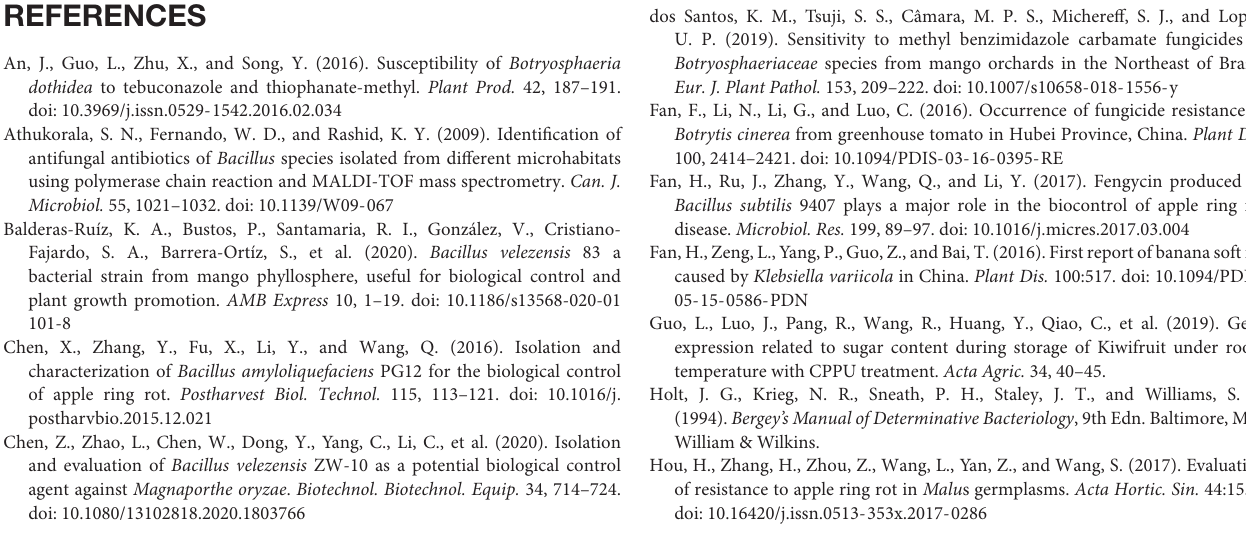
Supplementary Figure 1 | Test the carbendazim sensitivity of B . dothidea isolates. B . dothidea isolate Bd7 was used to value the carbendazim sensitivity. Carbendazim-sensitive isolate Bd220 was used as a negative control. The picture was taken at 5 dpi. Supplementary Figure 2 | PCR analysis of antibiotic biosynthesis genes from B. velezensis strain P2-1. M, Trans 2K DNA ladder, 1, ituD ; 2, ituA ; 3, srfA ;